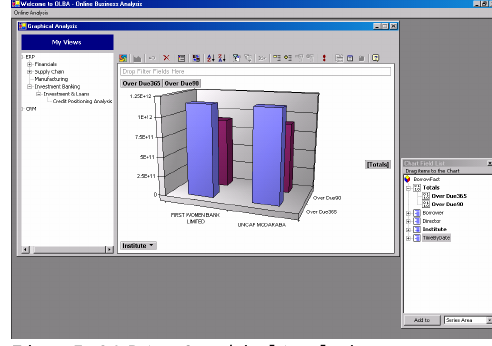
Figure5: OLBA – Graphical Analysis